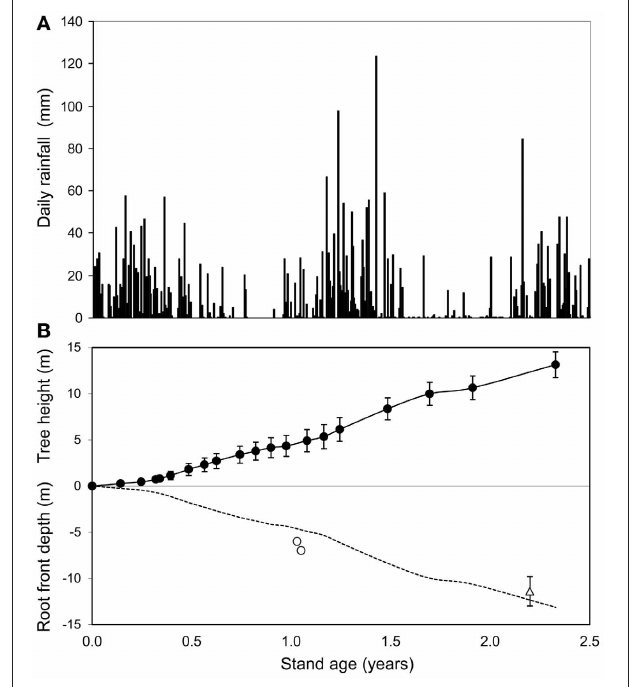
FIGURE 2 | Time series of volumetric soil water content at depths of 3 and 4m (A), 5 and 6m (B), 7 and 8m (C), and 9 and 10m (D). Vertical arrows at depths of 6 and 7m indicate the approximate age of the stand when water withdrawal at the root front led to a sharp decline in soil water content after stabilization resulting from a disruption of drainage from upper soil layers. The timecourse of soil water content at the other depths (3, 4, 5, 8, 9, and 10m) did not make it possible to estimate the stand age at the arrival of the root front. Trees were harvested ∼ 1 month before re-planting.